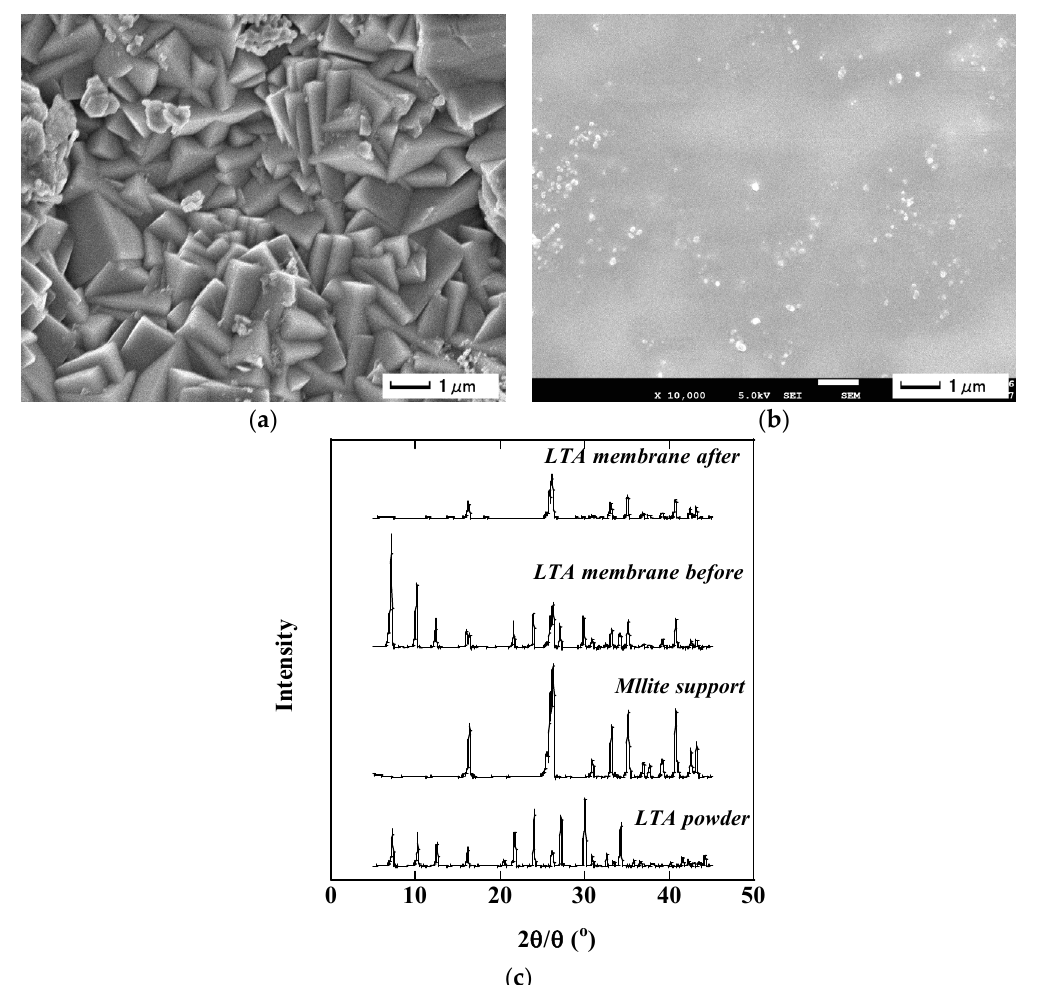
Figure 3. LTA membrane morphology: ( a ) fresh membrane surface; ( b ) membrane surface after treating the distillate; ( c ) XRD patterns.